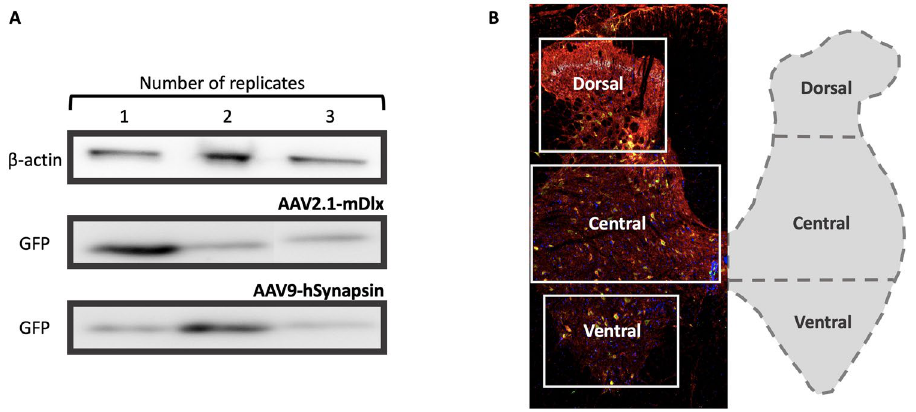
Figure 1. Expression of AAV viruses in the lumbar spinal cord of wild-type Wistar adult rats. ( A ) Western blots of the images confirming expression of two viruses, AAV2.1-mDlx-GCaMP6f-Fishell-2 (N = 3 rats) and AAV9- hSynapsin-soCoChR-GFP (N = 3 rats) with beta-actin as the reference protein. ( B ) Confirmation of expression was performed by visual inspection of the fluorescent reporter, where after immunohistochemistry was performed and cell colocalization and counting was performed in three dorsoventral regions of the lumbar cord 2 2 2 (D, 560 × 720 µ m ), central (C, 590 × 1070 µ m ) and ventral (V, 460 × 770 µ m ). Red color represents GAD65, green GFP (mDlx), cyan GAD67 and blue DAPI. Full length western blots are shown in the supplementary Fig.